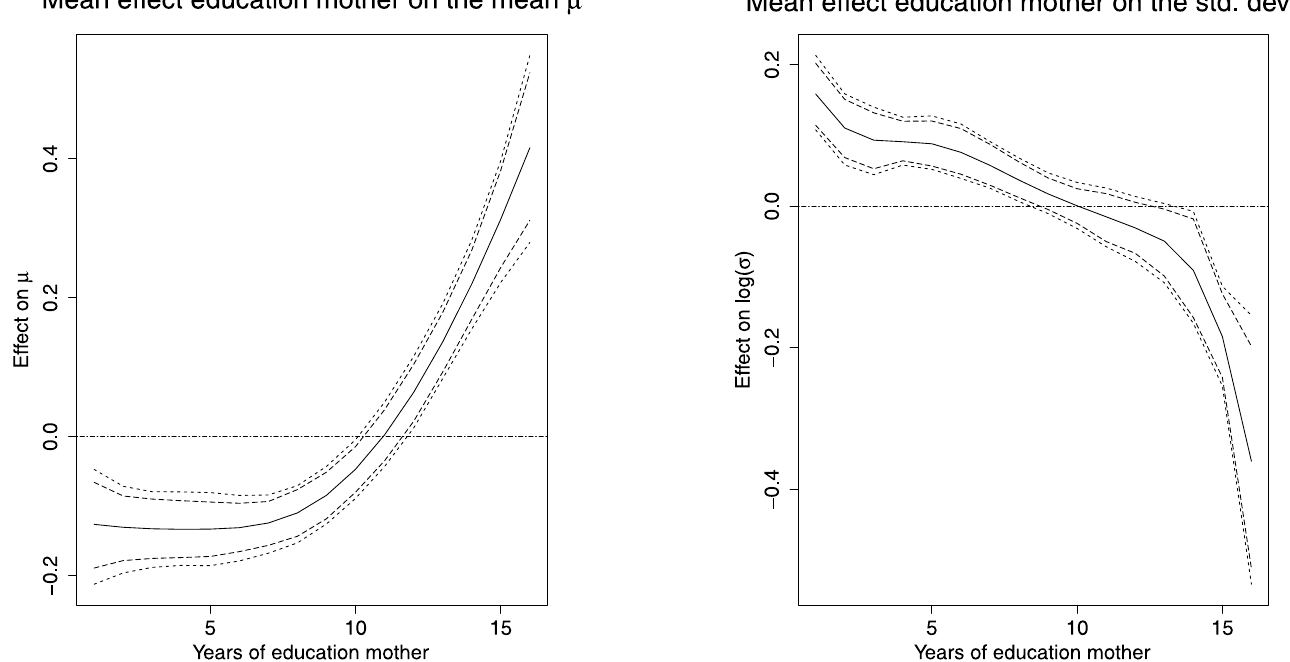
Fig 3. Non-linear effects of the asset index and the years of education. The Figure depicts the mean effects on the mean μ (left), and the standard deviation σ (right) together with 80 per cent and 95 per cent simultaneous credible intervals for the asset index (top), and the years of education of the mother (bottom). Source : Demographic and Health Surveys (data); calculation by